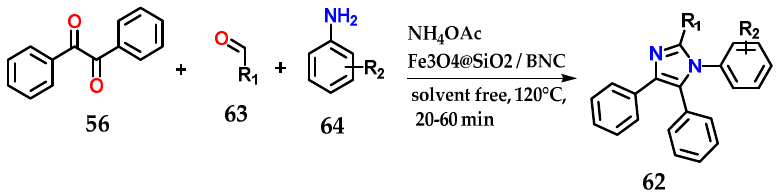
Figure 25. Tetrasubstituted imidazoles 62 were obtained through the condensation of benzyl 56 , aldehydes 63 and anilines 64 in the presence of ammonium acetate using Fe 3 O 4 @SiO 2 /BNC as a cat- alyst.